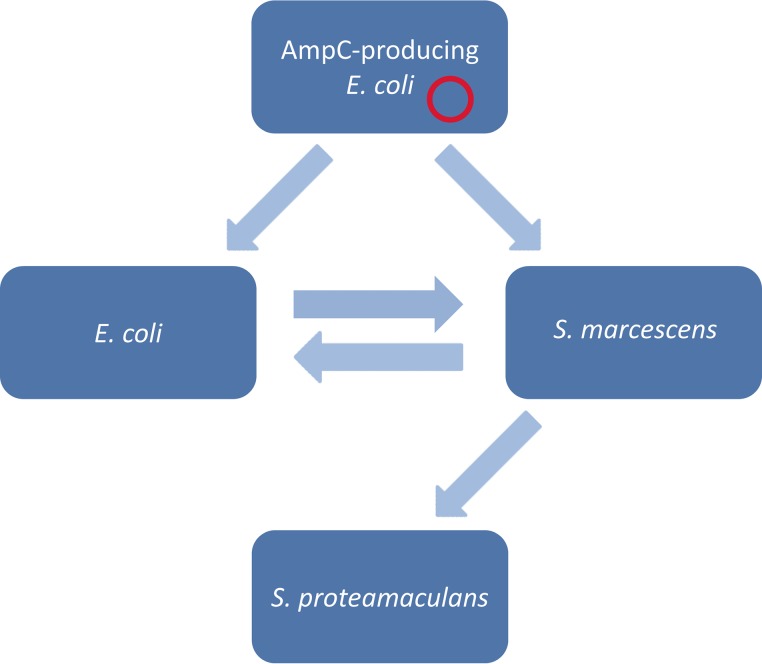
Schematic overview of confirmed routes of conjugative transfer in biofilm for the pNVI1292/IncK plasmid harboring blaCMY-2 commonly found in E. coli strains resistant to extended-spectrum cephalosporins isolated from retail chicken meat. The red circle symbolizes the IncK plasmid in the initial E. coli host. The arrows indicate the routes of transfer confirmed in this study.